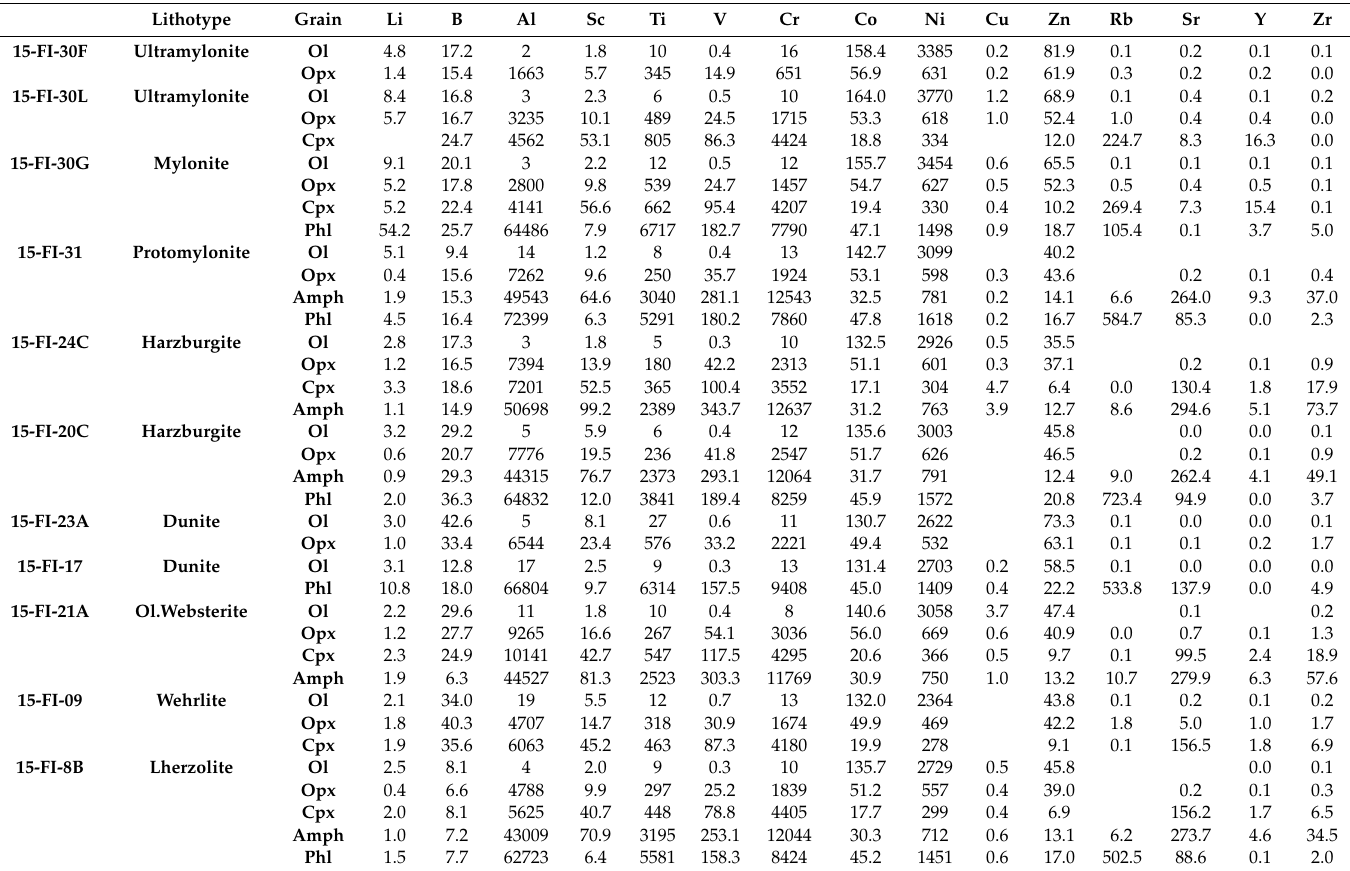
Table 3. Representative average trace element concentrations (ppm) of mineral phases in Finero ultramafic